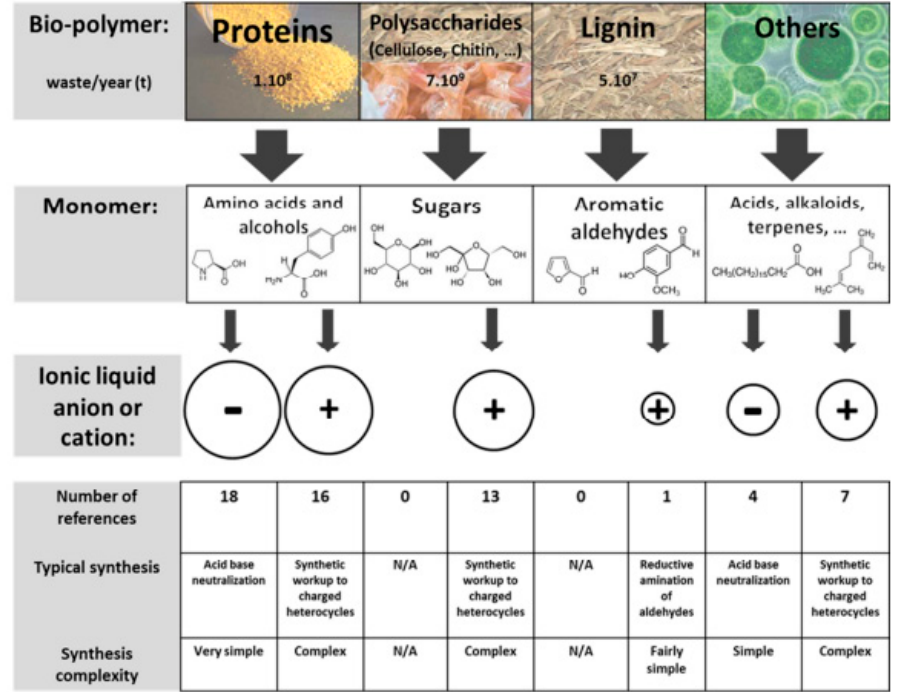
Figure 3. Synthesis pathways towards bio-based ILs. For each renewable resource class, typically derived monomers are indicated. The intensity of research (i.e., number of published papers) on converting these monomers into IL anions or cations is represented by the radius of the circle around the ‘ − ’ or ‘+’ sign, respectively. Typical synthetic routes and their complexity are mentioned where available. Reprinted with permission from [25].